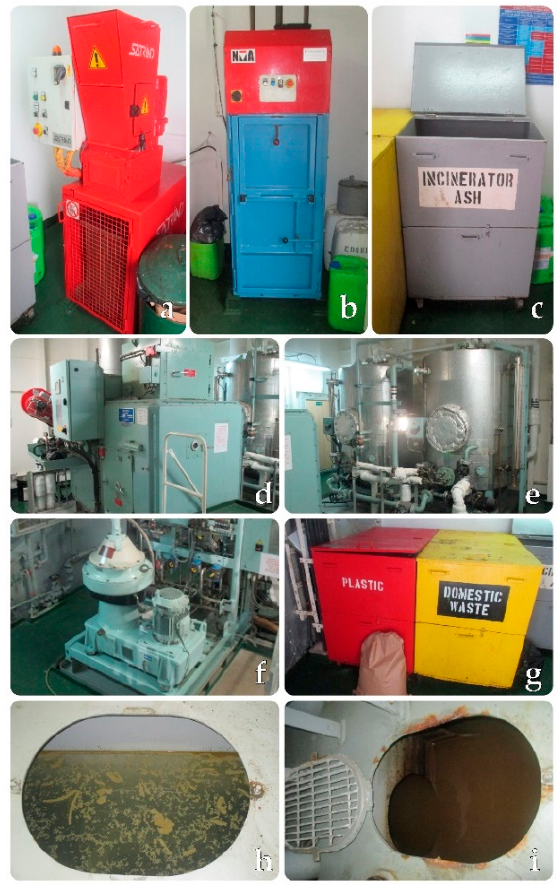
Figure 3. ( a ) Units involved in waste management on board ships: ship waste shredder; ( b ) ship waste compactor; ( c , g ) ship-generated waste collection and segregation; ( d ) ship waste incinerator; ( e ) oil derivatives processing tank; ( f ) oil separator unit; ( h , i ) oily bilge water and bilge well. Photo: Paweł